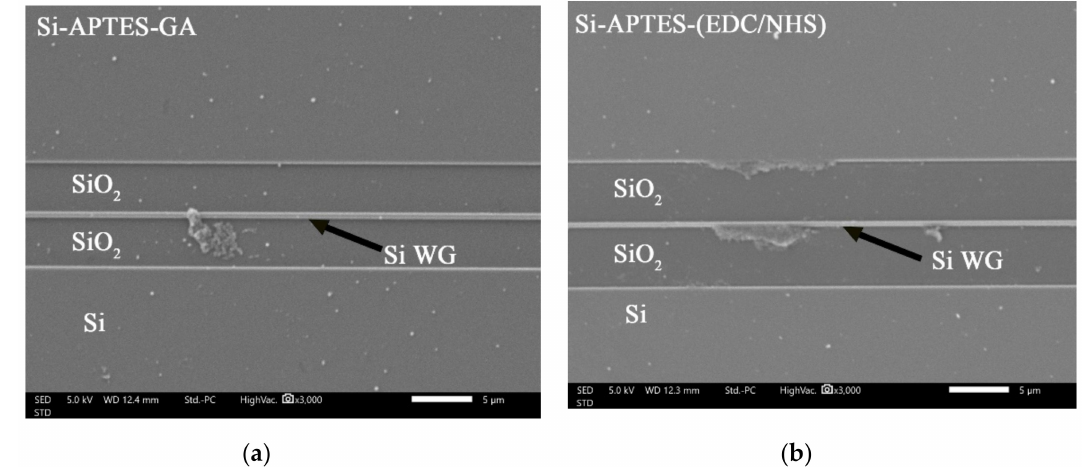
Figure 14. SEM images of anti-TNF-alpha coating of Si waveguides using ( a ) APTES-GA technique and ( b ) APTES- (EDC/NHS) technique.